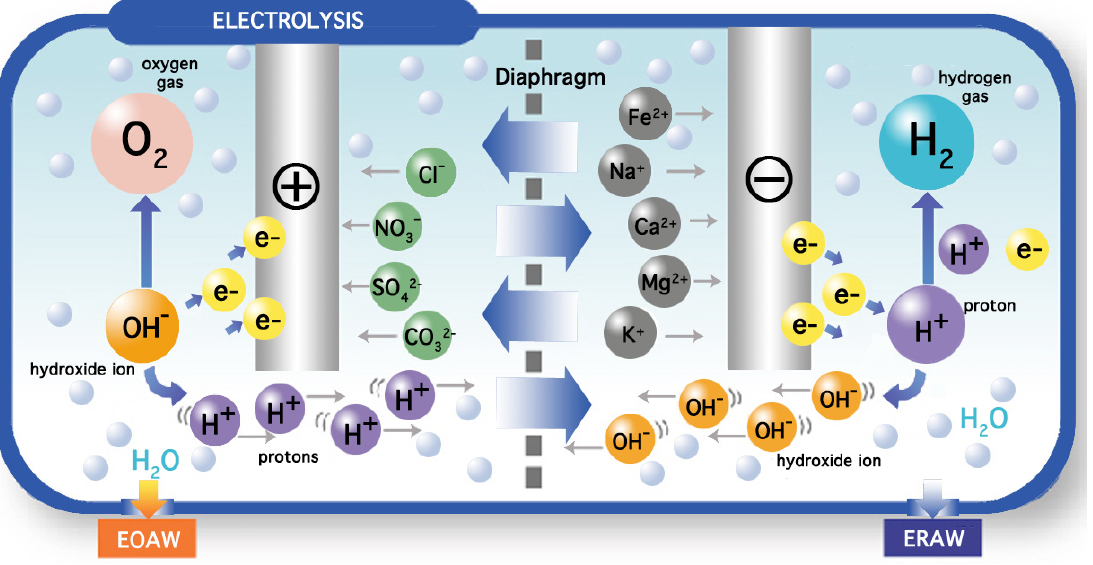
Figure 3. General overview of a commercial electrolyzed water